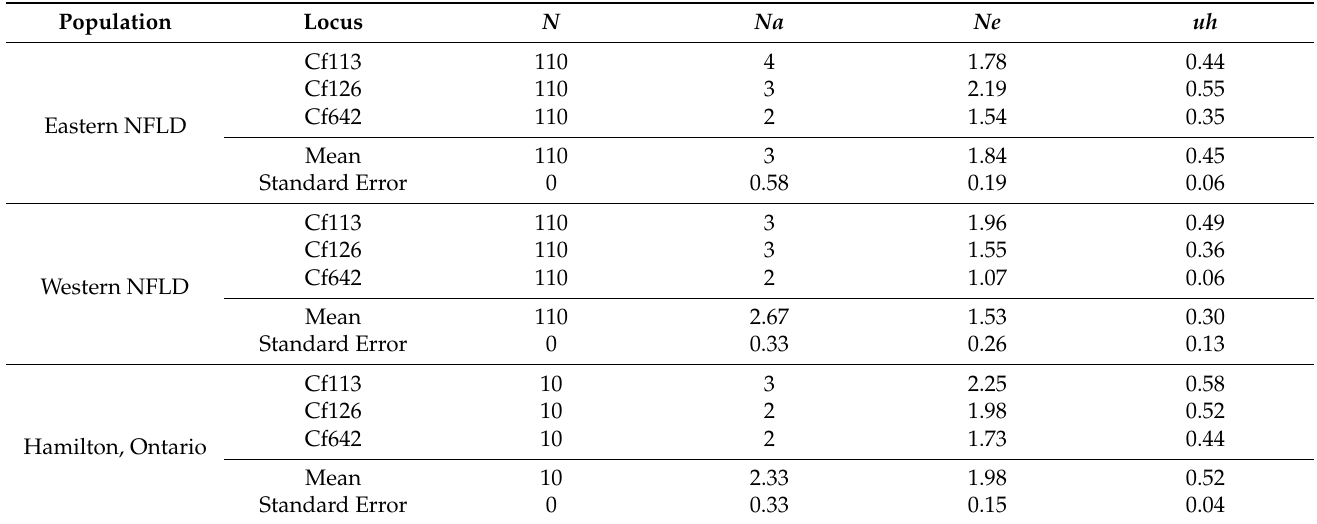
Table 1. Number of alleles and allelic diversity at the three microsatellite loci for the three regional populations of C. enelensis in Canada.